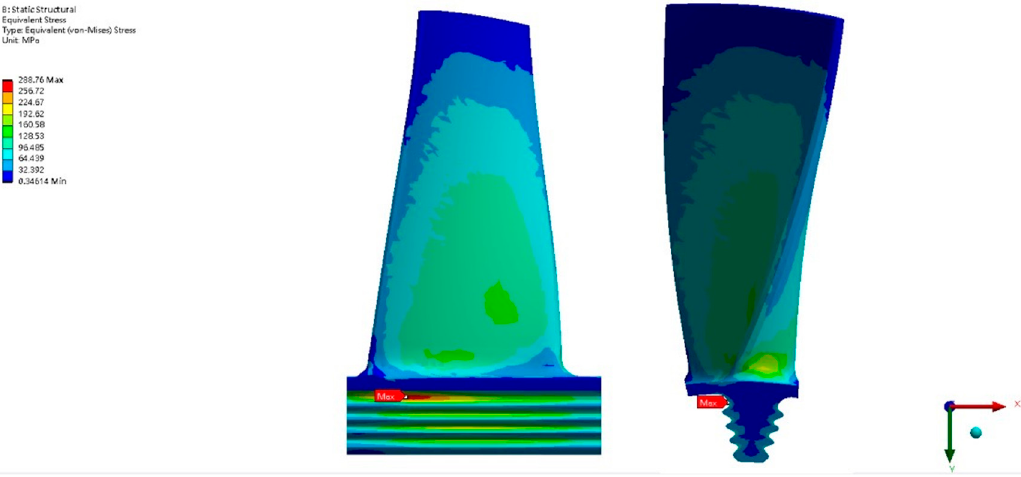
Figure 15. Stress result of centrifugal force analysis of the 2nd stage moving